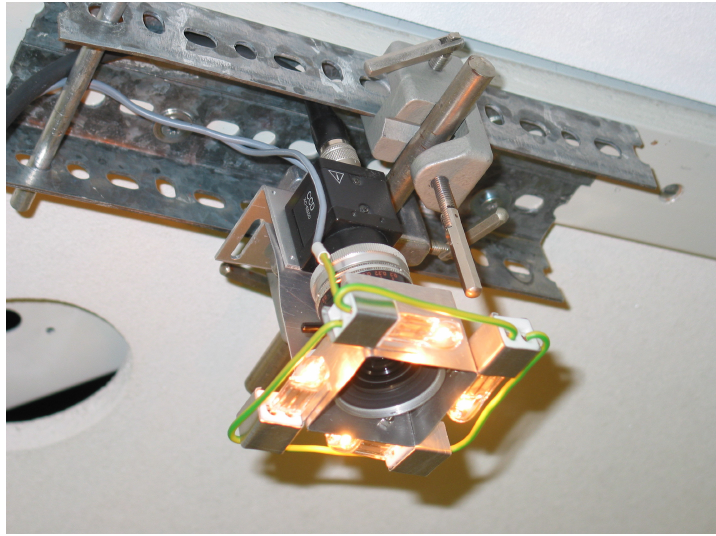
Figure 4. The sensor head is tracked by a compact analog video camera (Sony CCD XC-ES50) mounted at the ceiling of the lab 2.7 m above the reflex foil triangle plane on top of the sensor head. The attached high quality lens (Kern Macro-Switar, f = 10 mm) covers a FOV of 165 × 125 cm 2 on the ground. The lens is surrounded tightly by four halogen bulbs the brightness of which can be adjusted. Thus the image of the reflex foil triangle can be discriminated by its brightness and high contrast against the rest of the